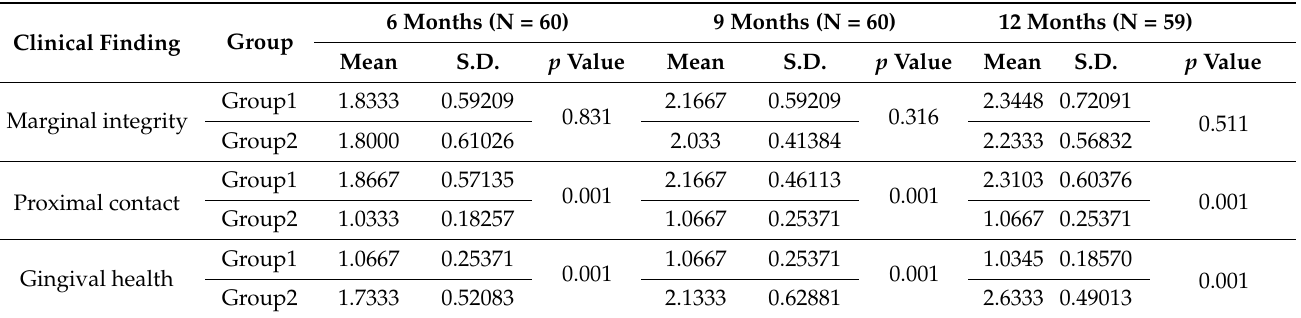
Table 4. Statistical evaluation of three parameters for the clinical evaluation of